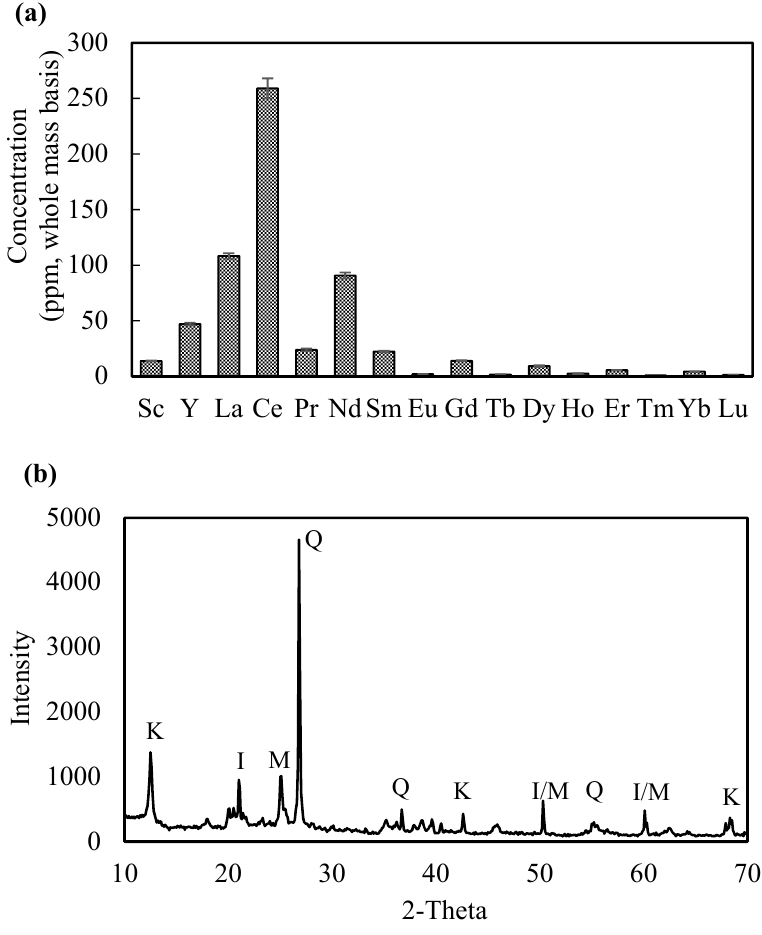
Figure 4. The composition of the acid leaching feed material used in this study on the basis of ( a ) rare earth content and ( b ) mineralogy as determined by X-ray diffraction analysis (Q—quartz, K—kaolinite, I—illite, M—muscovite).